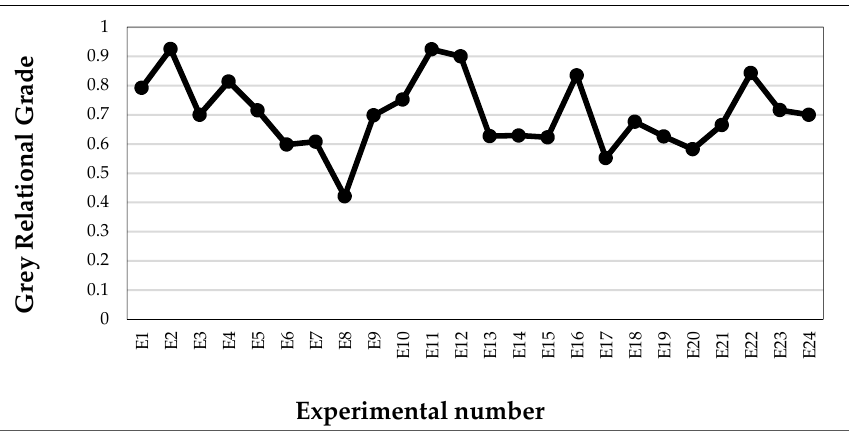
Figure 13. Grey Relational Grade for the section of chip and roundness deviation.